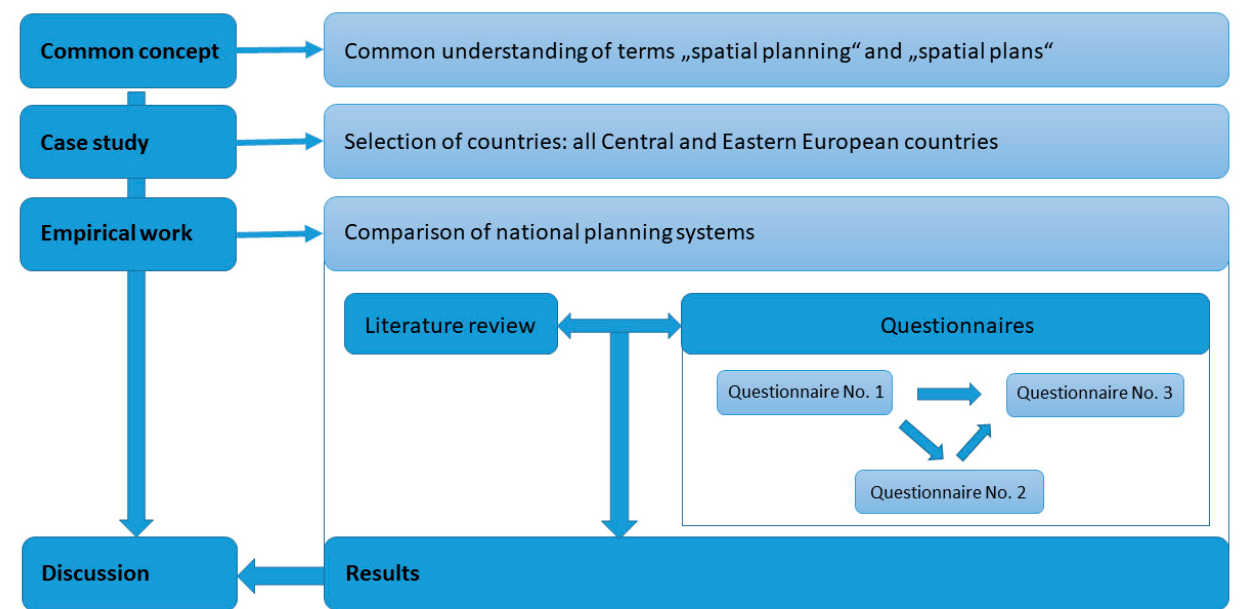
Figure 2. Research Figure 2. Research flow.